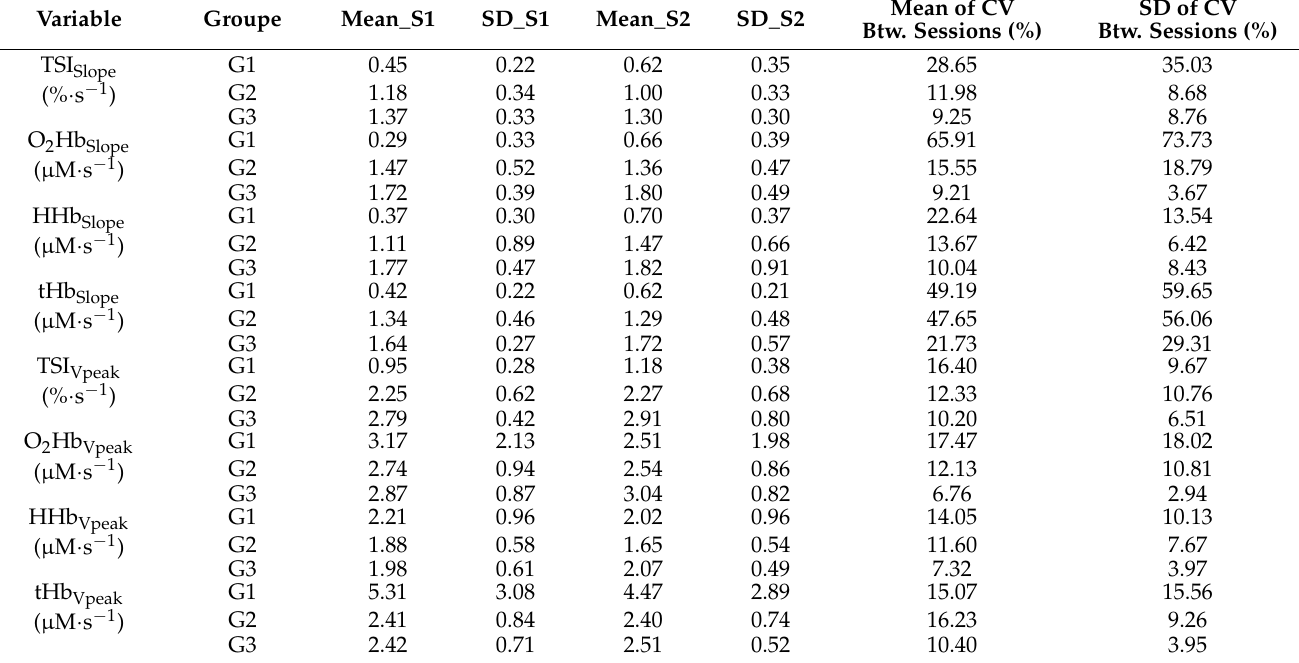
Table 12. Between-session variability of reoxygenation